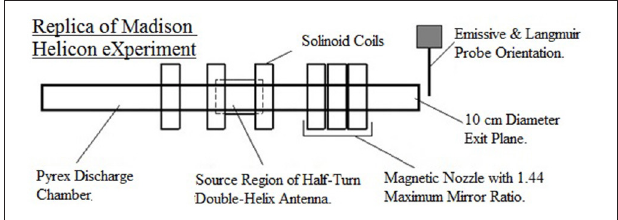
FIGURE 1 | Diagram of the MadHeX replica including probe orientation. Measurements are recorded at the thruster exit plane. Thruster components are shown to scale.